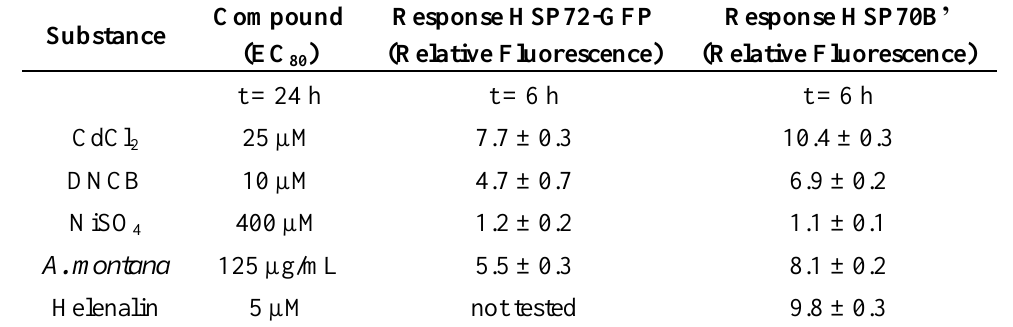
Table 1. Response of HSP72-GFP [9] and HSP70B′-GFP sensor cell to different forms of